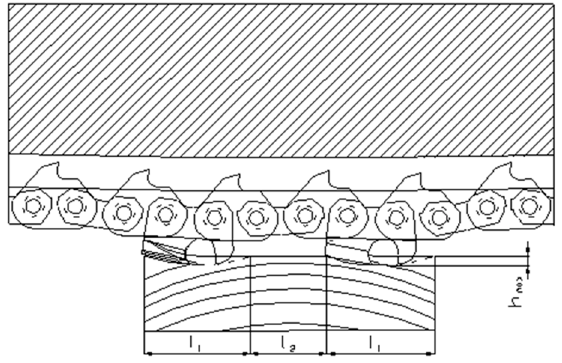
Figure 9. The course of the process of wood cutting with a saw chain: h max —maximum chip thickness, l 1 —distance covered by cutter inside the wood, l 2 —distance covered by cutter outside the wood.